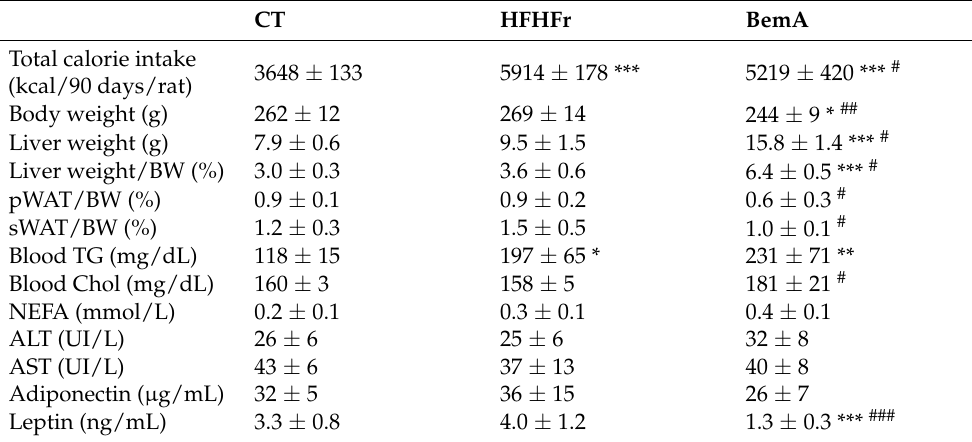
Table 1. Zoometric parameters and blood, serum, and liver analytes. CT HFHFr